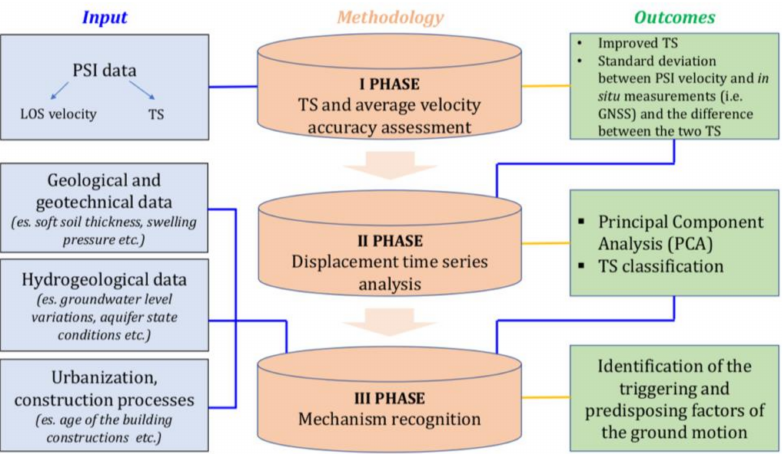
Figure 3. Flowchart of the methodological approach to detect and characterize uplift phenomena in urban